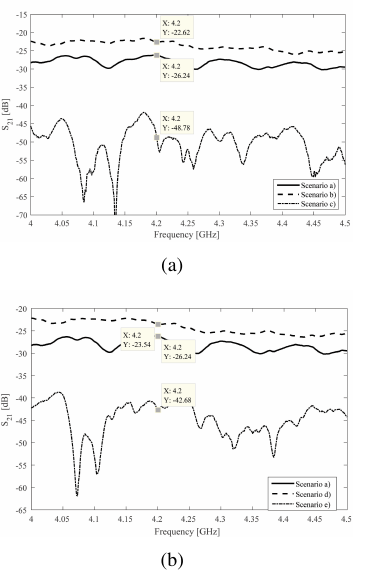
Figure 10: (a) Measurements for the metal plate configura- tion; (b) Measurements for the FSS configuration